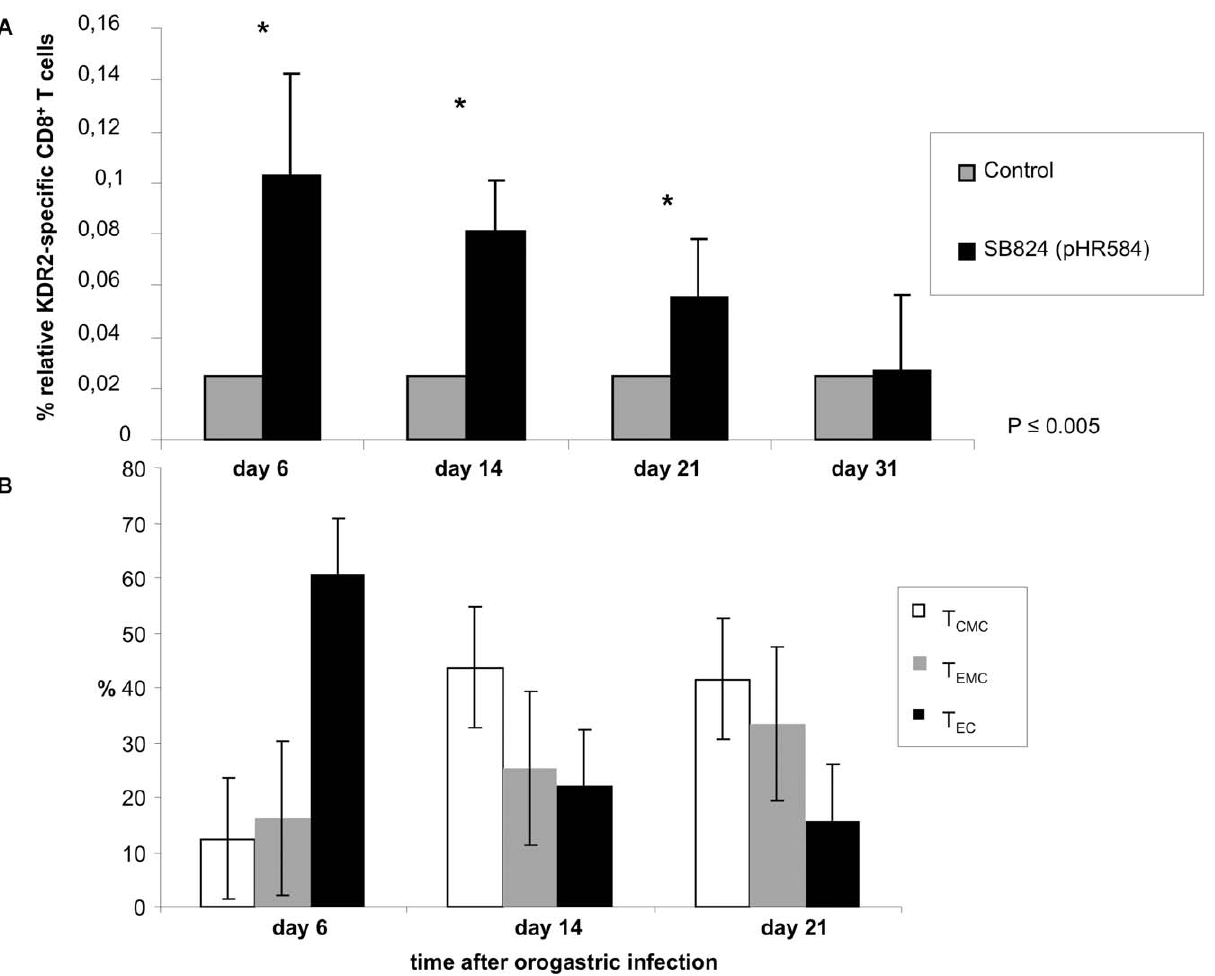
Figure 3. KDR2-specific CD8 T-cell response and kinetics of KDR2 400–408 -specific CD8 T cell subpopulations. A MHC tetramer staining using tetrameric H2-Kd/KDR2 400–408 complexes and flow cytometric analysis of murine spleen cells were performed on days 6, 14, 21 and 31 after single orogastric immunization with Salmonella SB824 (pHR584). Relative numbers of H2-K d /KDR2 400–408 -tetramer-positive CD8 T cells are shown for five mice vaccinated with SB824 (pHR584) (black bars) and for five non-immunized mice (grey bars, control). Asterisks indicate values that differ significantly from the corresponding values obtained from mice of the control group (*, p # 0.005). B Differentiation patterns of KDR2 400–408 -specific CD8 T cells into phenotypically distinct subsets on days 6, 14, and 21 after single orogastric vaccination with Salmonella SB824 (pHR584) are displayed as % of KDR2 400–408 -specific CD8 T cells. KDR2 400–408 -specific CD8 T cells were stained for expression of CD127 and CD62L and analyzed by flow cytometry. CD127 high /CD62L high central memory CD8 T cells, T CMC , white bars; CD127 high /CD62L low effector memory CD8 T cells, T EMC , grey bars; CD127 low /CD62L low effector CD8 T cells, T EC , black bars. Each experiment was performed at least twice with similar results.